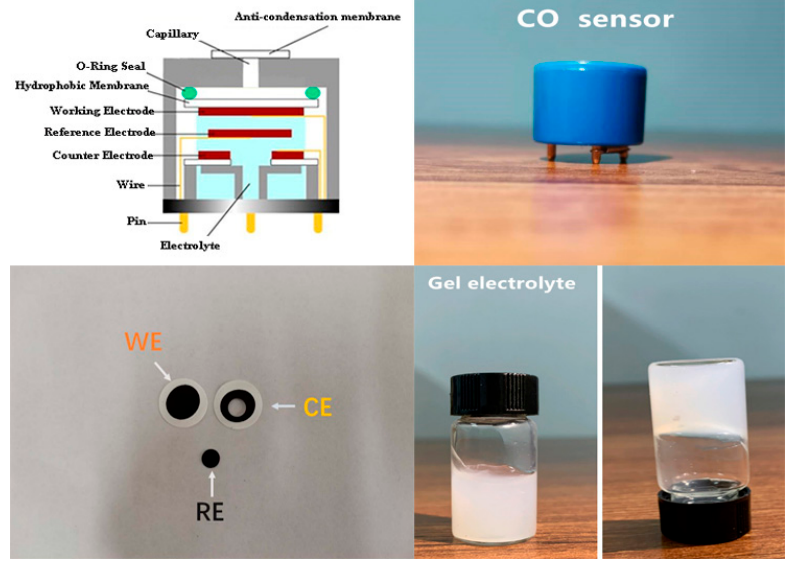
Figure 1. The schematic diagram of the sensor structure with the photos of electrodes, sensor and gel. Chemosensors 2020 , 8 , x FOR PEER REVIEW